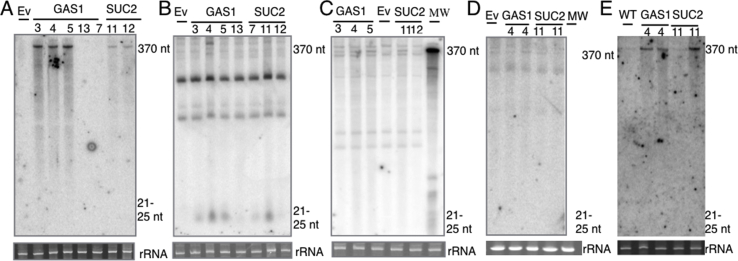
Northern blot analyses of ds-GFP in transgenic tomato plants and whiteflies feeding on the plants. (A) Plant RNA with HMW RNA extraction and HMW RNA hybridization protocols. (B) Plant RNA with LMW RNA extraction and LMW RNA hybridization protocols. (C) Whitefly with HMW RNA extraction and HMW RNA hybridization protocols. (D) Whitefly with LMW RNA extraction and LMW RNA hybridization protocols. (E) RNA extracted from the scion apex heterografted (GAS:4 and SUC2:11) plants. RNA was extracted from tomato leaves (A,B,E) and from ca. 250 adult whiteflies that had fed on transgenic plants for two weeks (C,D), and the samples (20 μg RNA per lane) were separated on 8% denatured urea-acrylamide gel. Numbers indicate transgenic tomato lines, with Ev, the negative control, comprising tomato plants transformed with the empty vector. WT, wild-type tomato, MW, molecular weight. The rRNA loading control is SybrGold stained 5S rRNA. The bands of molecular weight intermediate between 370 nt GFP and candidate sRNAs (21–25 nt) were interpreted as non-specific binding of plant and whitefly RNA to the GFP probe because they were detected in both the experimental samples and Ev controls. The LMW RNA extraction protocol (B, D) reduced, but did not exclude HMW RNA, particularly yielding multiple bands >> 21–25 bp in the plant samples (B) that were detectable with the low stringency of the LMW hybridization protocol required to visualize 21–25 bp bands.